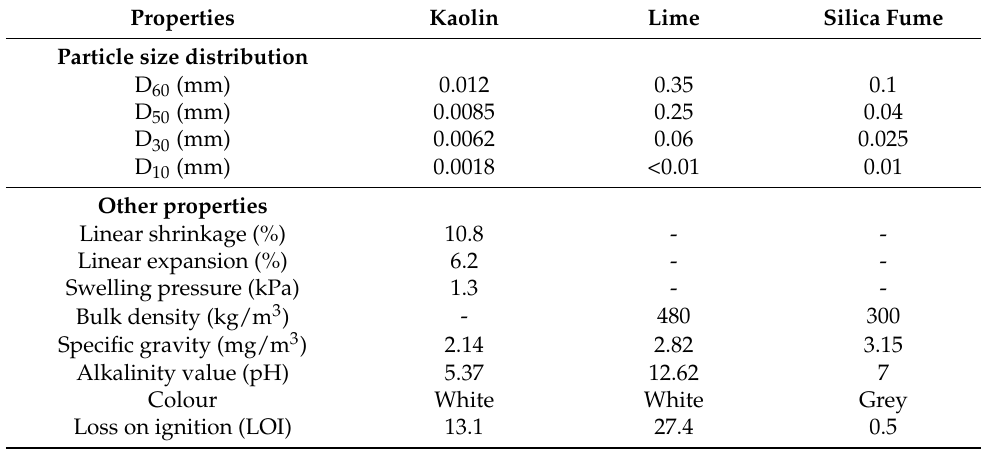
Table 2. Grading and some other physical properties of the raw materials.